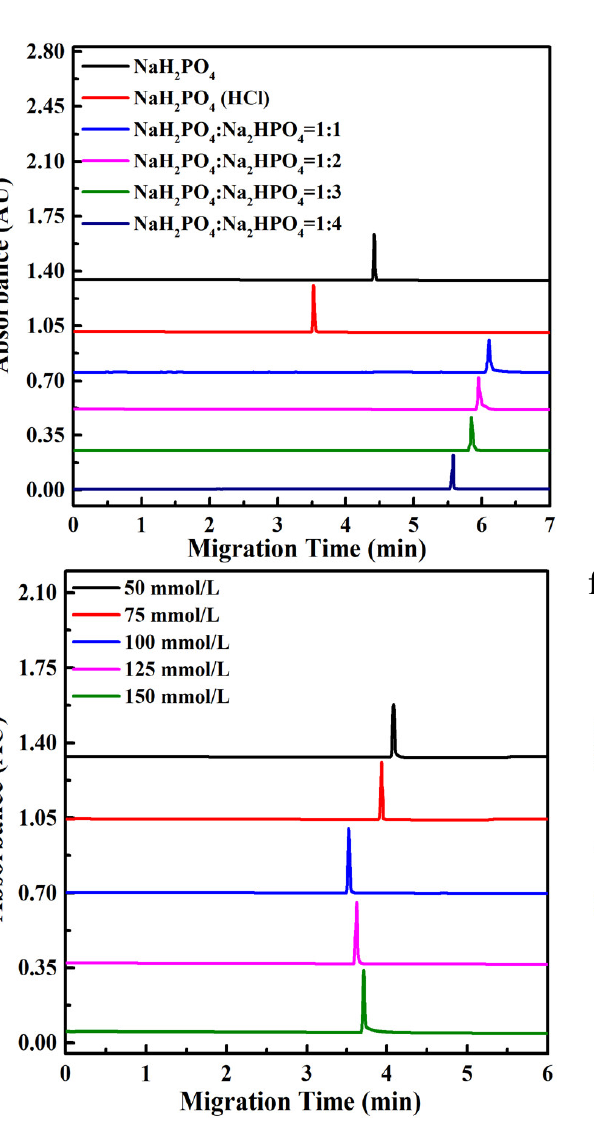
Figure 2. ( a ) Effect of the eluent ratio (methyl alcohol/acetic acid, v / v = 100:0 (A), 95:5 (B), 90:10 (C) and 80:20 (D)) on the CE peak area of a 100.0 μg/L histamine solution. ( b ) Effect of the eluent volume on the CE peak area of a 100.0 μg/L histamine solution. ( c ) Effect of the type of running buffer (100 mmol/L) at 10 kV applied voltage on the CE absorbance of a 1.0 mg/L histamine solution. ( d ) Effect of the pH of running buffer (100 mmol/L) at 10 kV applied voltage on the CE absorbance of a 1.0 mg/L histamine solution. ( e ) Effect of the concentration of running buffer (pH 2.5) at 10 kV applied voltage on the CE absorbance of a 1.0 mg/L histamine solution. ( f ) Effect of the CE separation voltage at 100 mmol/L running buffer (pH 2.5) on the CE absorbance of a 1.0 mg/L histamine solution.